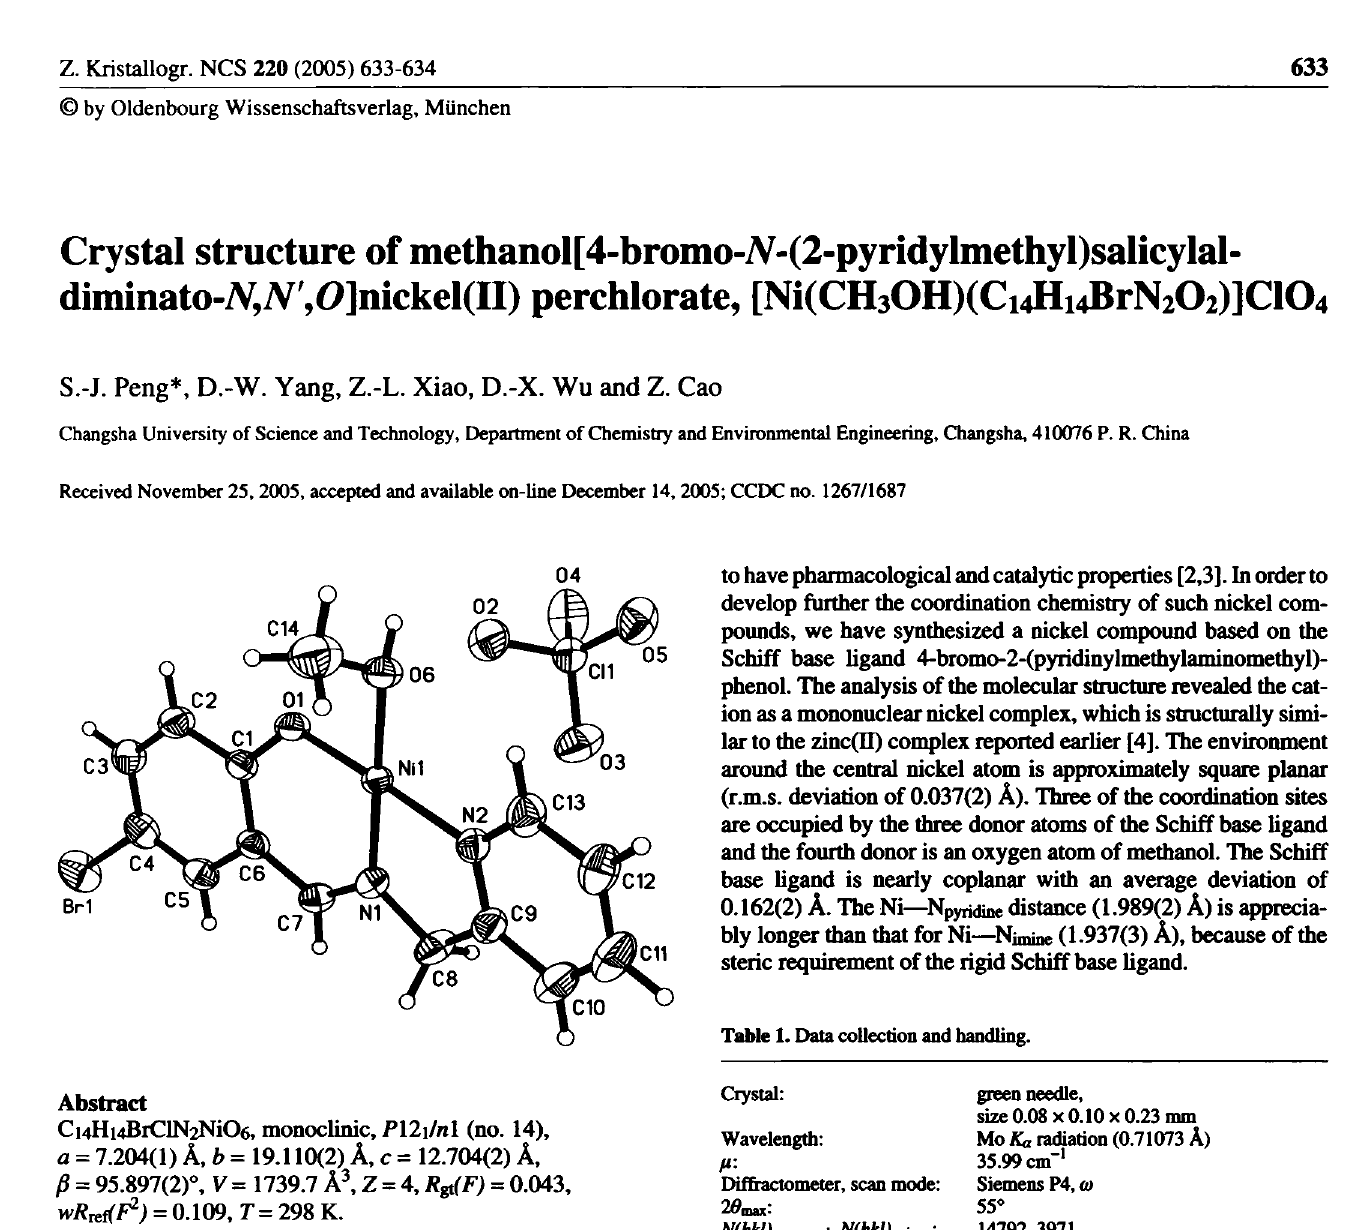
Table 2. Atomic coordinates and displacement parameters (in A 2